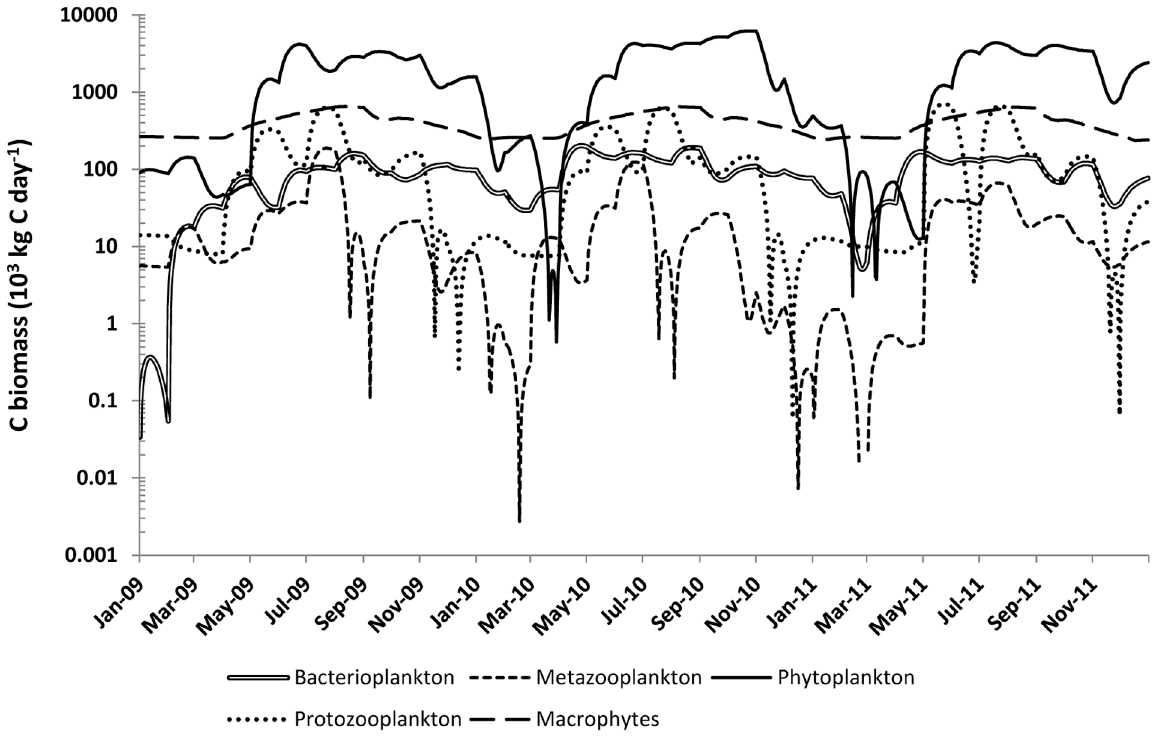
Figure 1. Dynamics of lake-wide functional groups biomass (10 3 kg day 2 1 ) during the 2009–2011 period Biomass values are shown on a logarithm scale for clarity purposes.